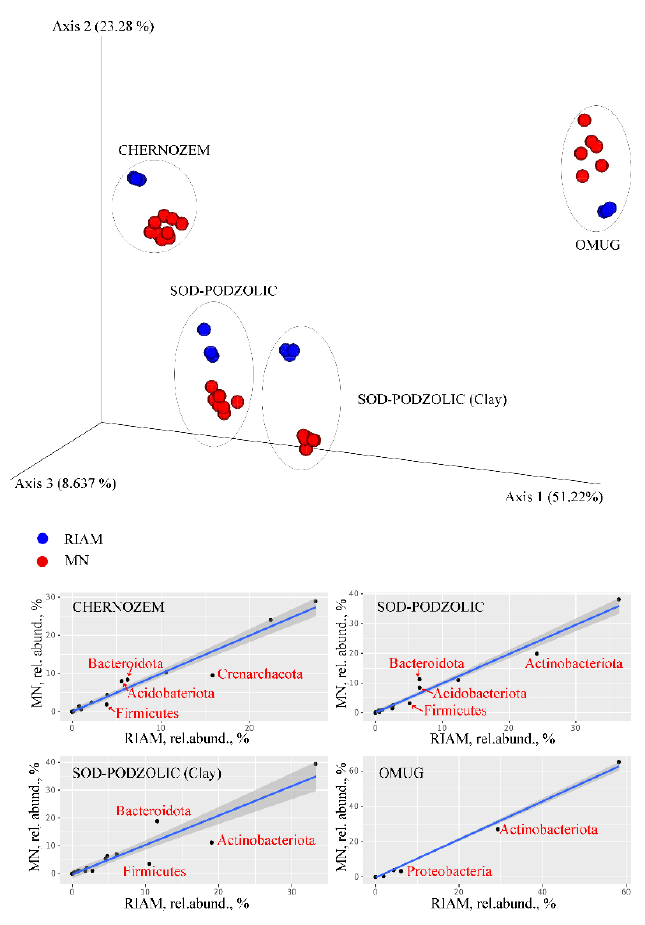
Figure 2. 16S rRNA high-throughput sequencing analysis results. In the upper part of the figure, the analysis of β -diversity (PCoA based on the weighted UniFrac metric) is presented. MN—four buffer variants with NucleoSpin Soil kit, RIAM—the protocol developed in this study. In the lower part of the figure comparison of relative abundances of prokaryotic phyla is plotted demonstrating the difference in abundances in MN libraries (the mean for all buffers) and RIAM. Phyla with statistically